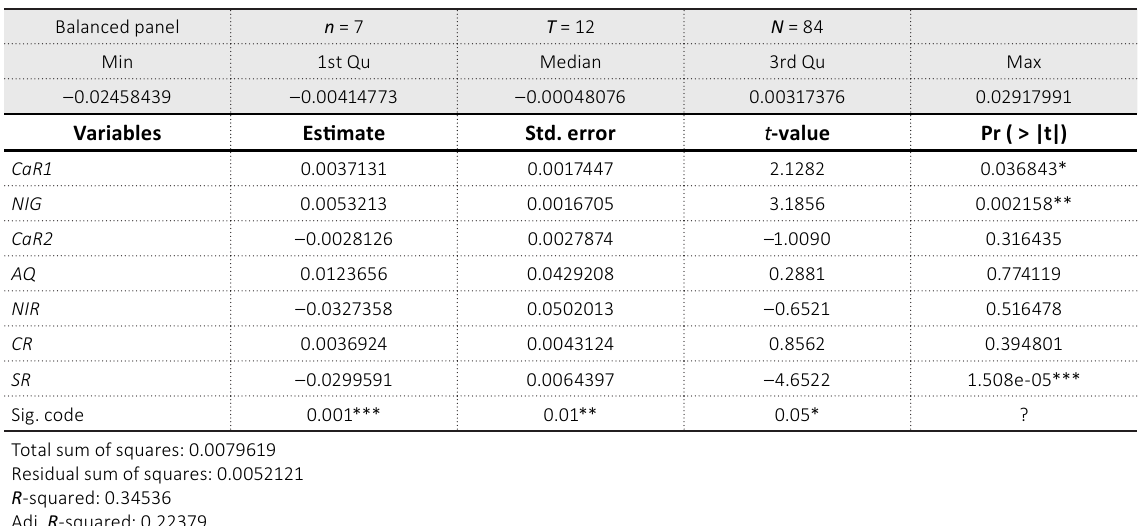
Table 4. Fixed effect regression model on Return on Assets